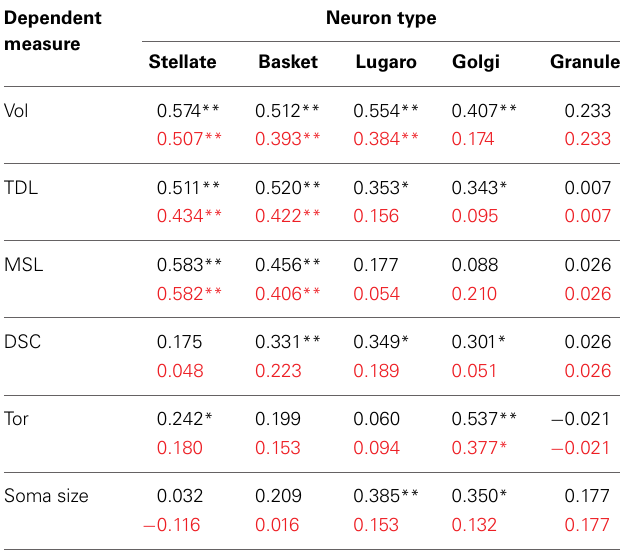
Table 3 | Matrix of Spearman’s rho correlations between cerebellar volume and dendritic measures (and soma size) across all neuron types.